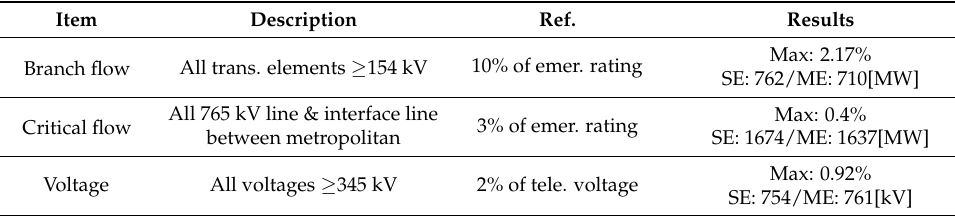
Table 18. Results for testing the performance requirements based on ERCOT.